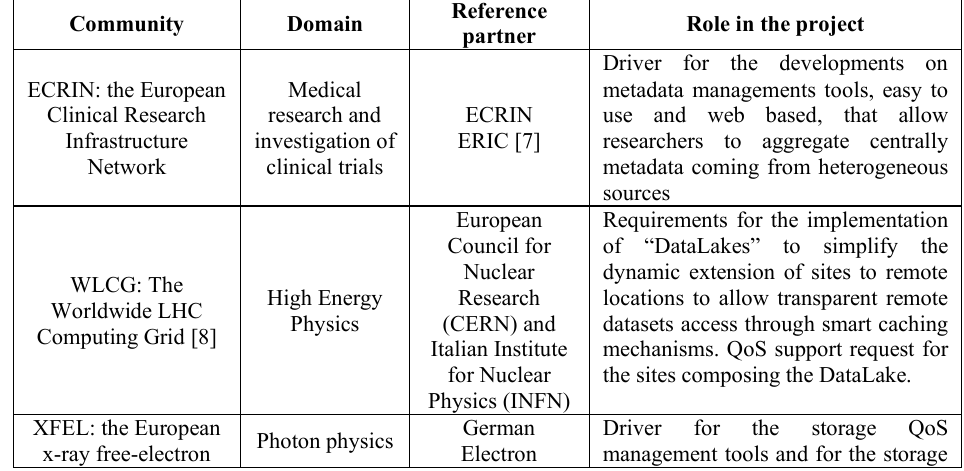
Table 1 - XDC represented User Communities